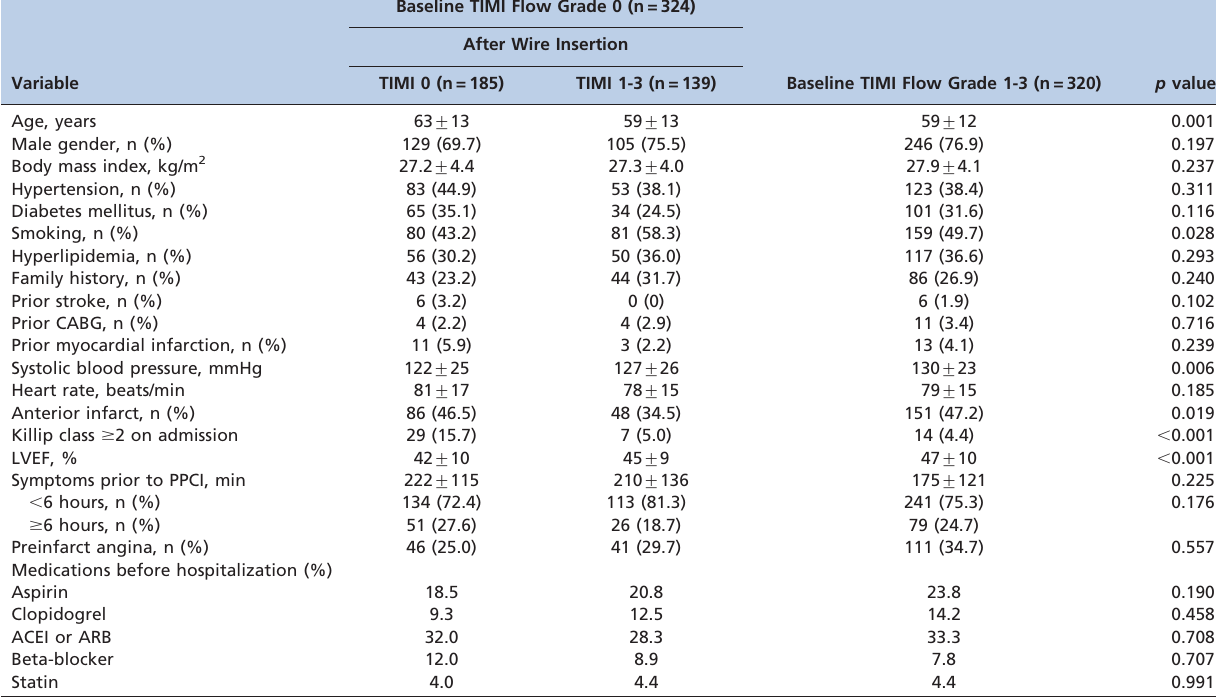
Table 1 - Baseline characteristics and prior medications of the study